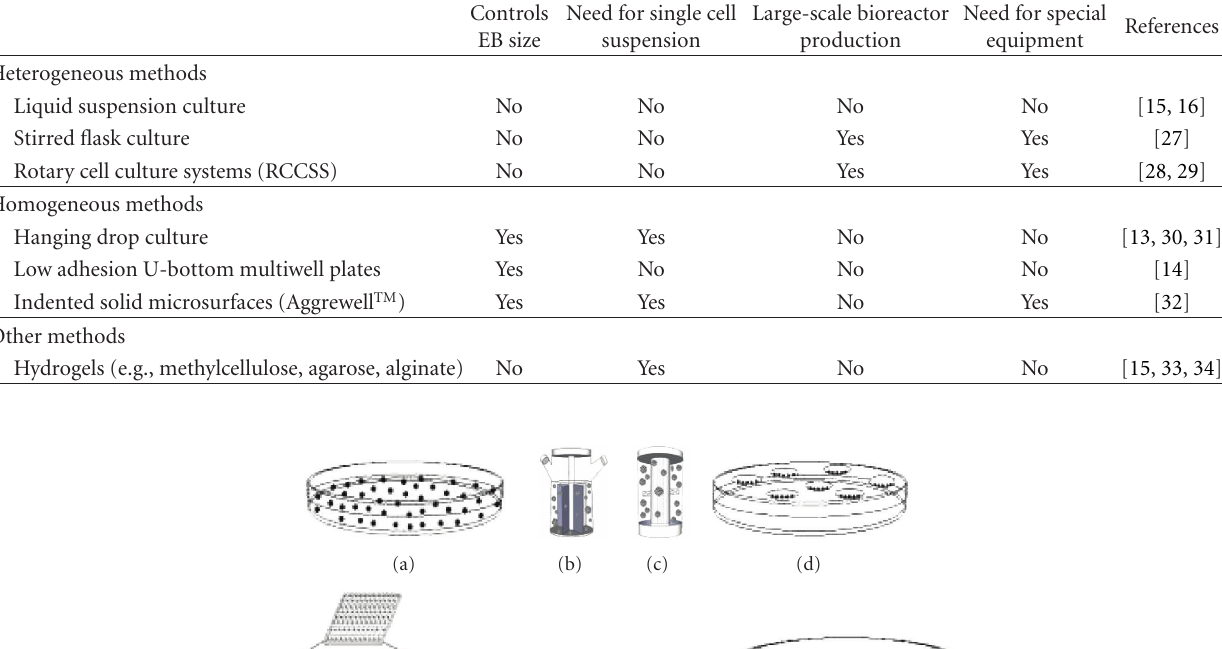
Table 1: Common techniques to form human embryoid bodies.